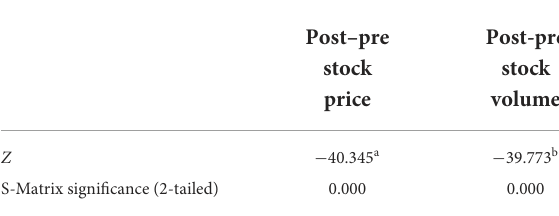
TABLE 1 Wilcoxon signed ranks